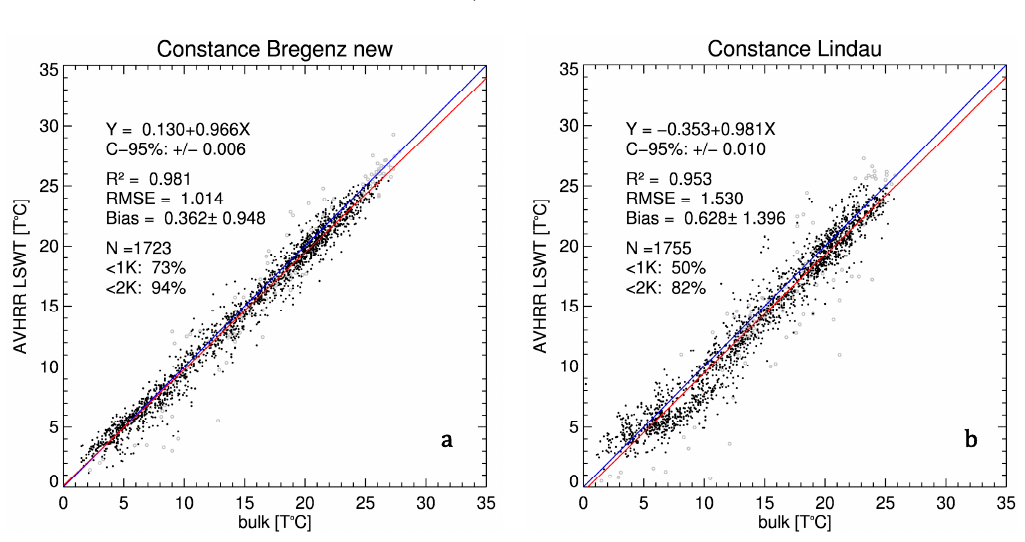
Figure 6. The validation with hourly averaged measurements at Lake Constance for the station in Bregenz ( a ) and for the station in Lindau ( b ). Both show a good performance and a high number of matchups despite the in-situ locations close to the shore. However, the correlation with the satellite data is significantly higher in Bregenz ( a ) than in Lindau ( b ). For both validations, the same satellite data is used.